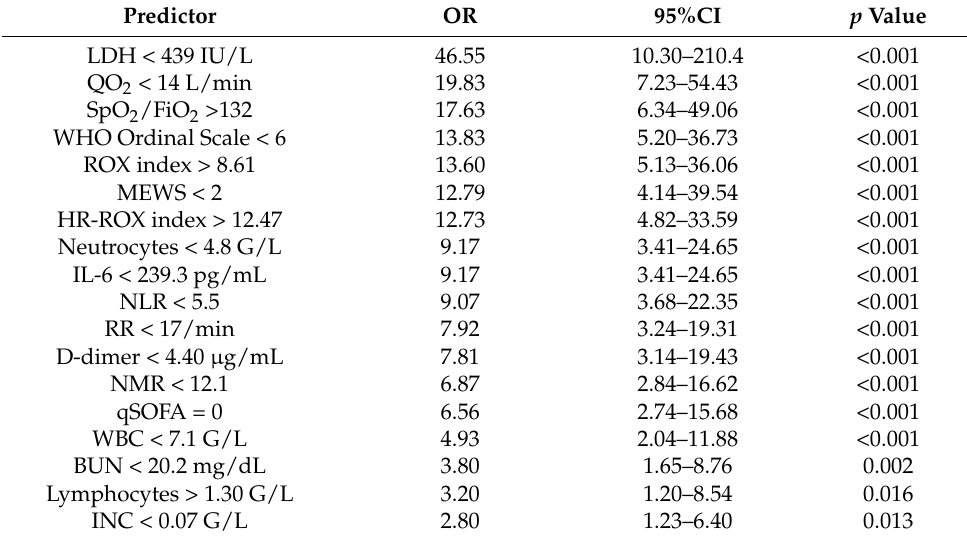
Table 4. Clinical and laboratory early predictors of good response (on 2nd day after TCZ) identified in univariate logistic regression analysis on adjusted data.